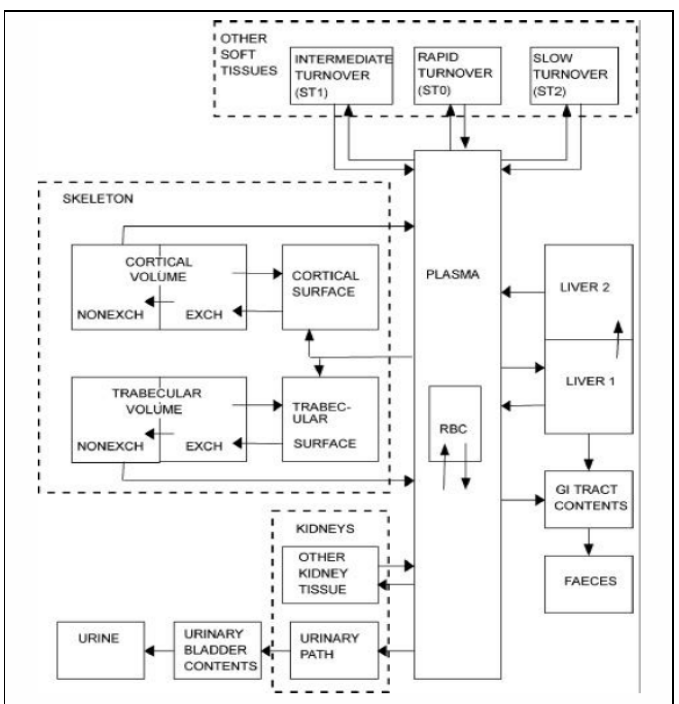
Figure 3. Biokinetic model for uranium